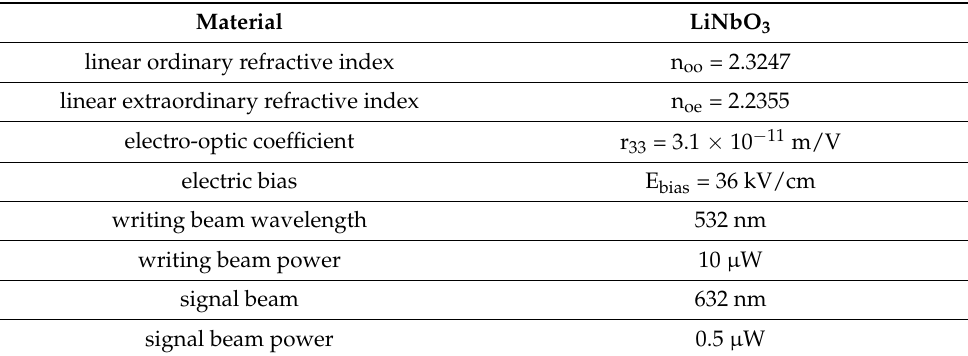
Table 5. Numerical parameters used in the soliton